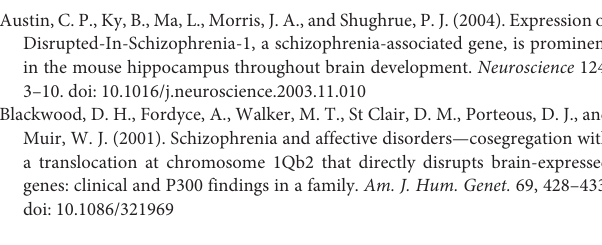
FIGURE 4 | DISC1 regulates the dendritic development of adult born neurons in the rat hippocampus. (A) Sample projections of Z -series confocal images of GFP + neurons at 2 and 4 wpi. Scale bar: 10 µ m. (B) Total dendritic length of GFP + neurons at 2 and 4 wpi. Numbers indicated in each bar graph represent the total number of neurons analyzed from 3–8 animals under each